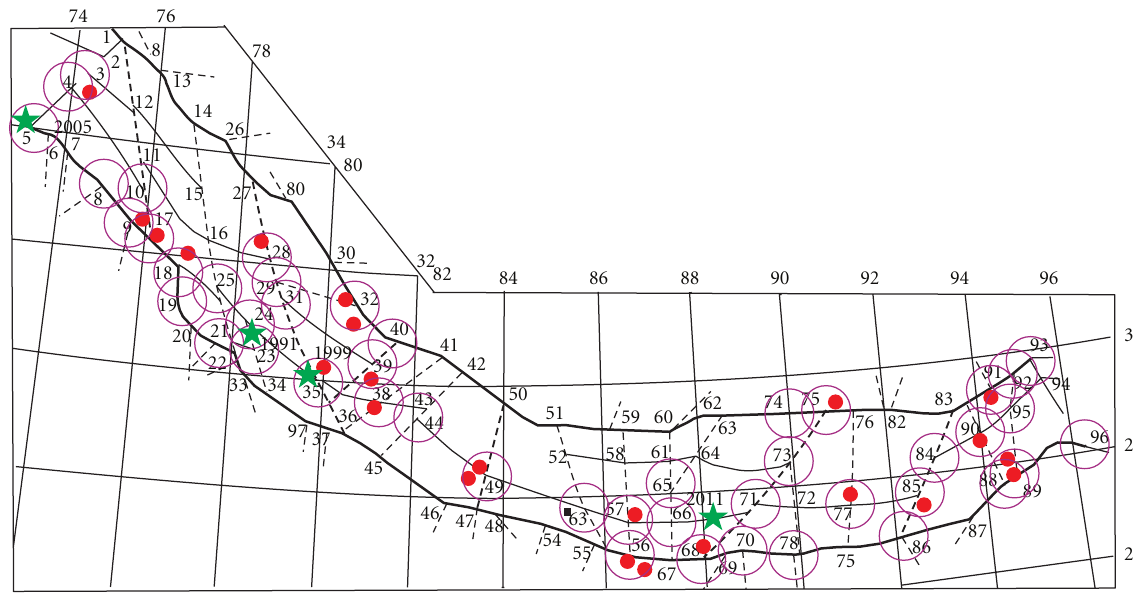
Figure 1: Himalaya: MZ map, seismogenic nodes for M6.5+, and post-publication earthquakes M6.5+.